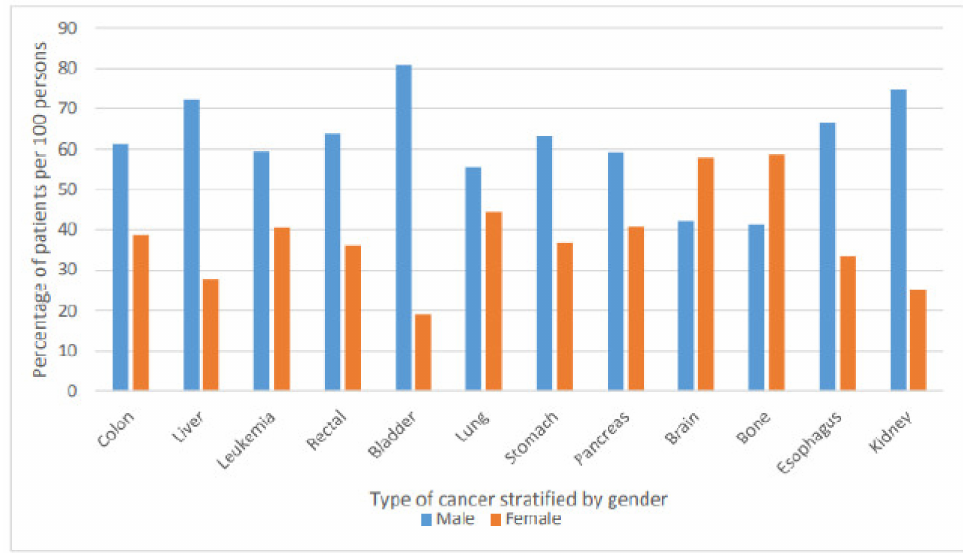
Figure 3. Type of cancer stratified by gender.